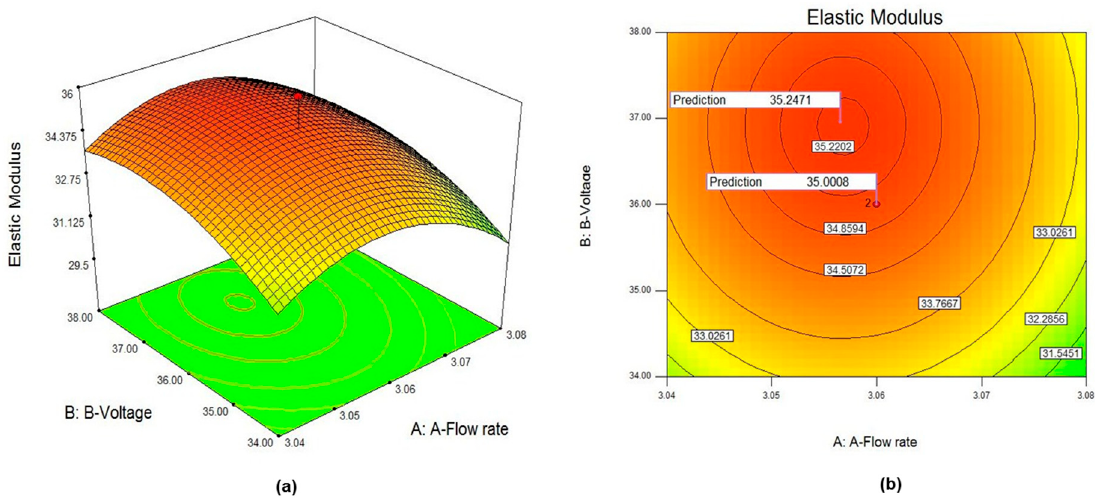
Figure 4. Plots of: ( a ) 3D surface response; and ( b ) counter plot of quadratic model for elastic modulus.